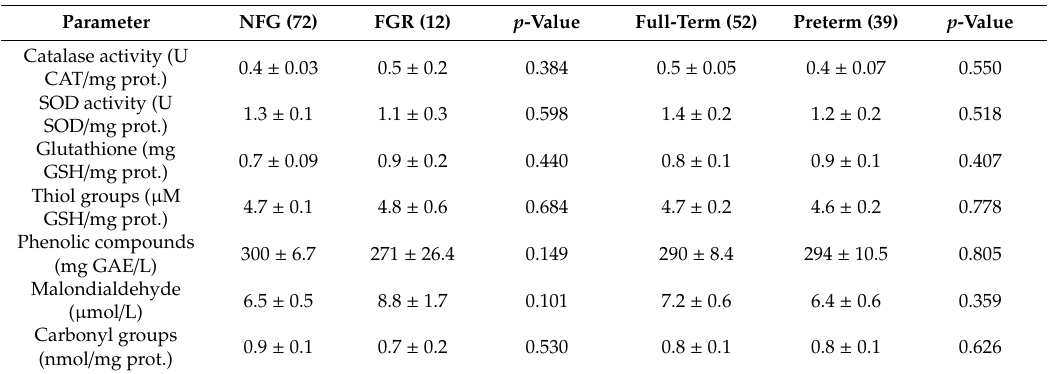
Table 3. Maternal plasma antioxidants and biomarkers of oxidative damage, according to the development of FGR or preterm